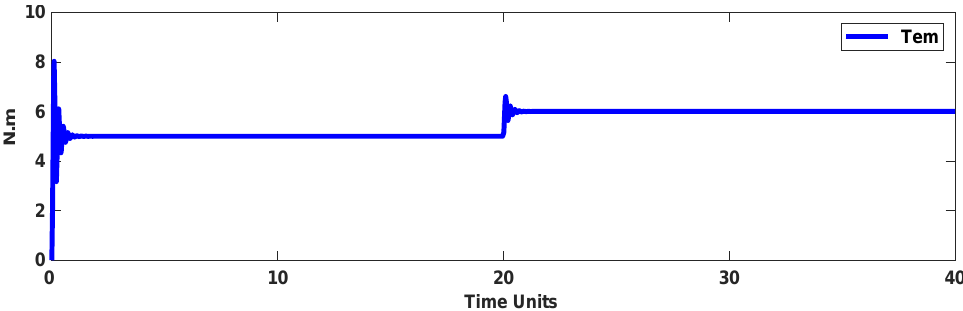
Figure 8. Load torque in the faulty